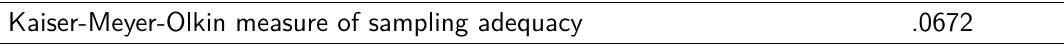
Table 1. KMO and Bartlett’s test Kaiser-Meyer-Olkin measure of sampling adequacy .0672 Bartlett’s test of sphericity Approx. Chi-square 2144.180 df